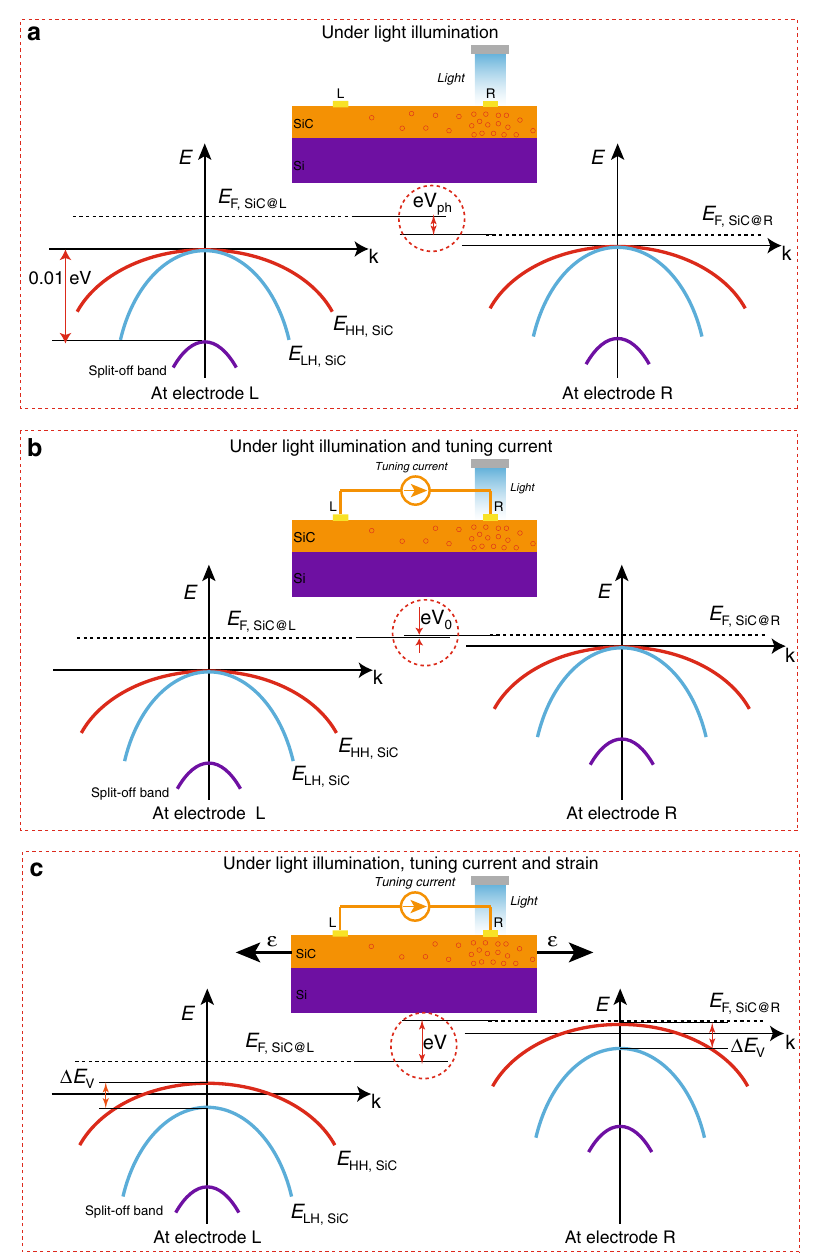
Fig. 6 E – k (energy – momentum) characteristics of 3C-SiC nano fi lms under different conditions. a E – k characteristics at electrode L and electrode R under illumination. b Under illumination and tuning current. c Under illumination, tuning current and applied